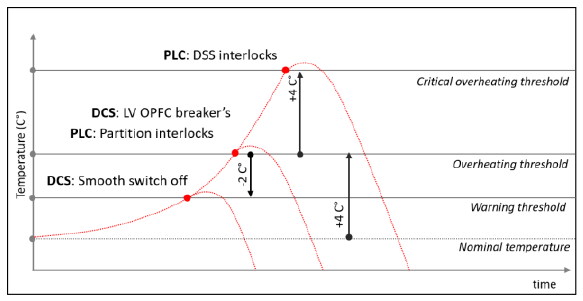
Fig. 3. Multi-layered set of actions on temperature sensors In combination with the ESS, the CMS ECAL DCS configures a multilayer set of actions that go from soft preventive actions at the supervisory level, to hardwired interlocks at the DSS level, ensuring the safety of the ECAL detector in a comprehensive and robust